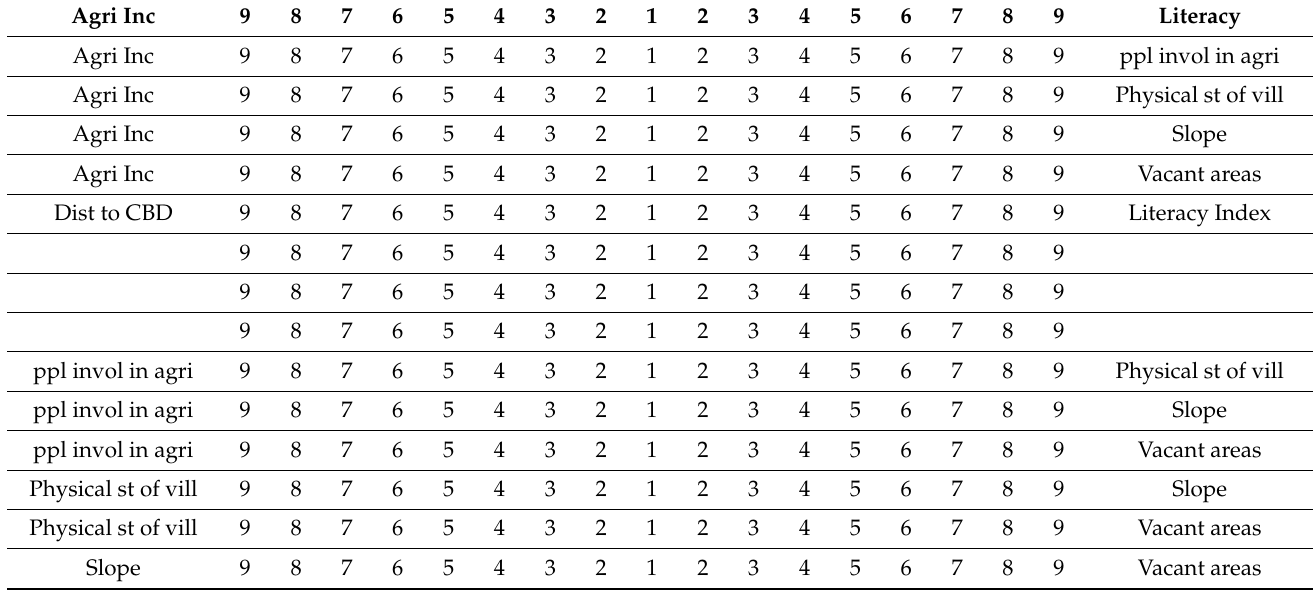
Table 3. Questionnaire for the experts for weighting and ranking the parameters.